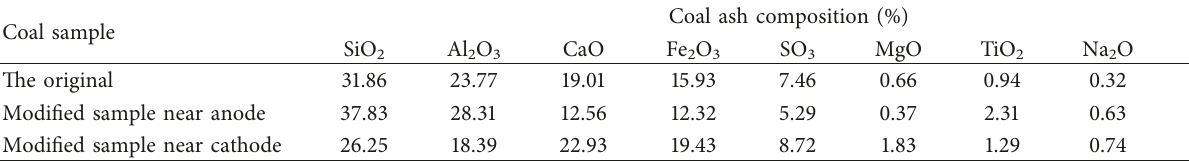
Table 2: The test result of coal ash composition.